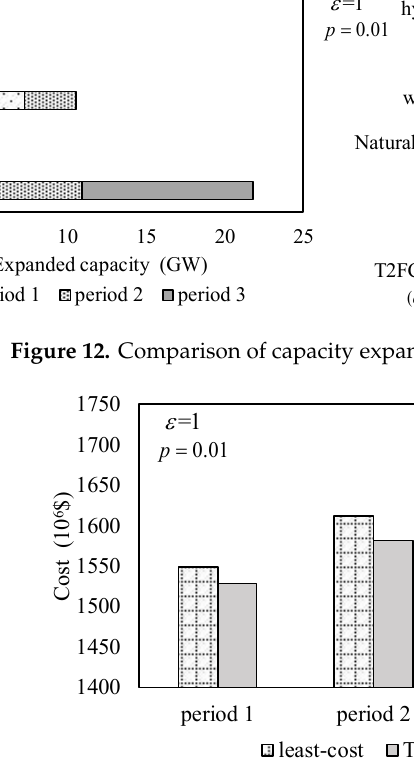
Figure 13. Comparison of total cost for pollutant treatment and pollutant emission from two models.